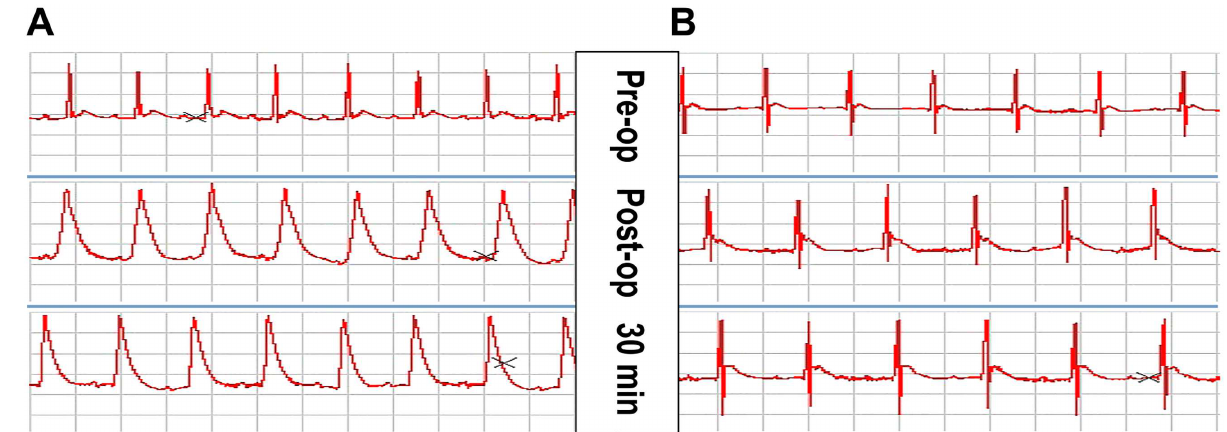
Fig 1. ECG changes at lead II after acute myocardial infarction (AMI) in rats. (A) ECG of the AMI group. The follow-upECG after AMI shows ST segment elevationat lead II lastingover 30 min. (B) ECG of the Sham group. The follow-upECG 30 min after surgery was similar to the